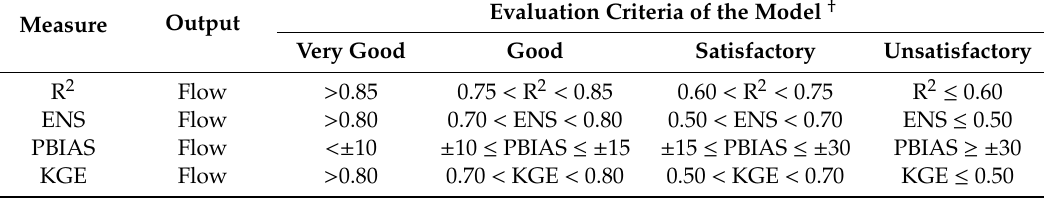
Table 6. SWAT performance evaluation criteria according to Moriasi et al. [74], Thirel et al. [75], and Lee et al. [64].